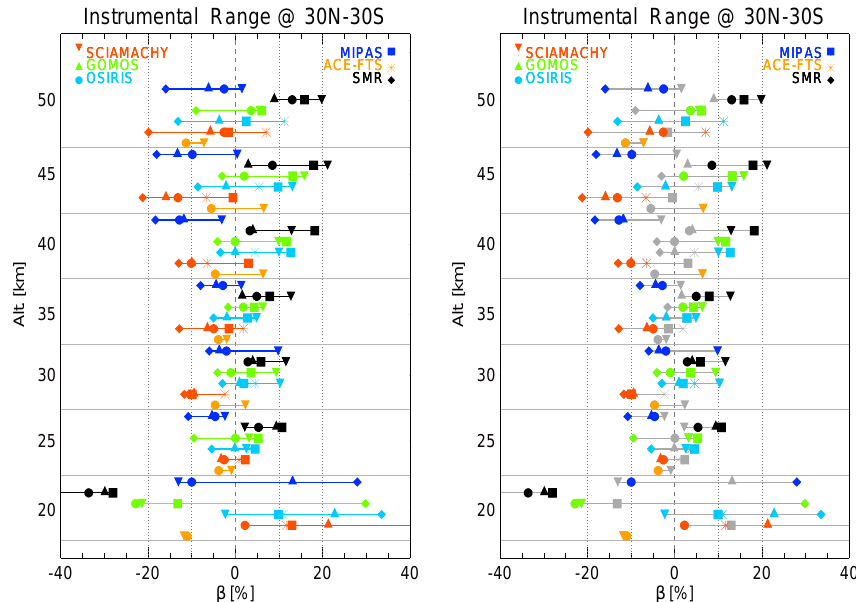
Figure 4. (a) “Pairwise relative bias” ( β ) range for all sensors as a function of altitude in the tropical band (30 ◦ S–30 ◦ N). Reference sensors are indicated by colour and individual comparison sensors by corresponding symbols. (b) Same as (a) but only significant β values are shown (non-significant values are shaded out).